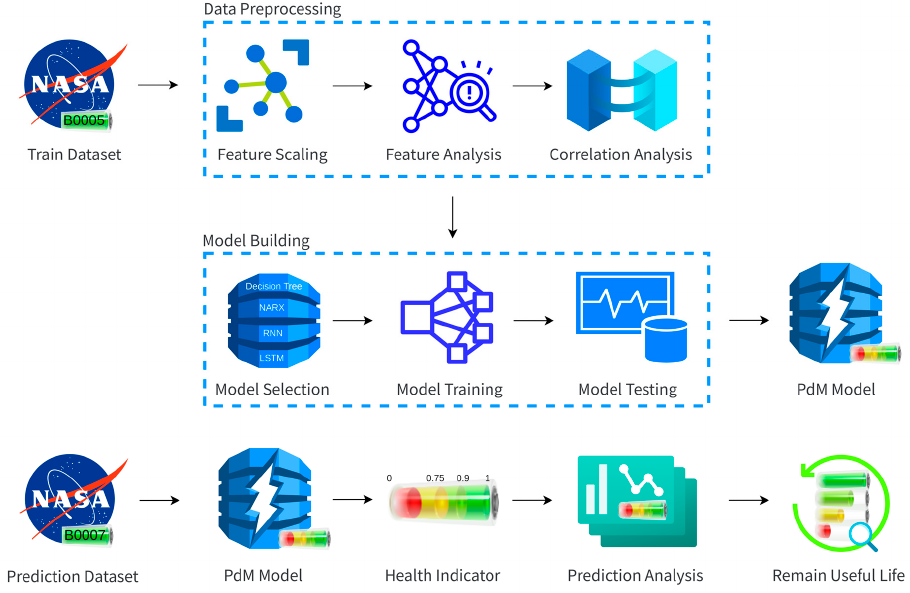
Figure 2. Framework for the predictive maintenance of Li-ion batteries.